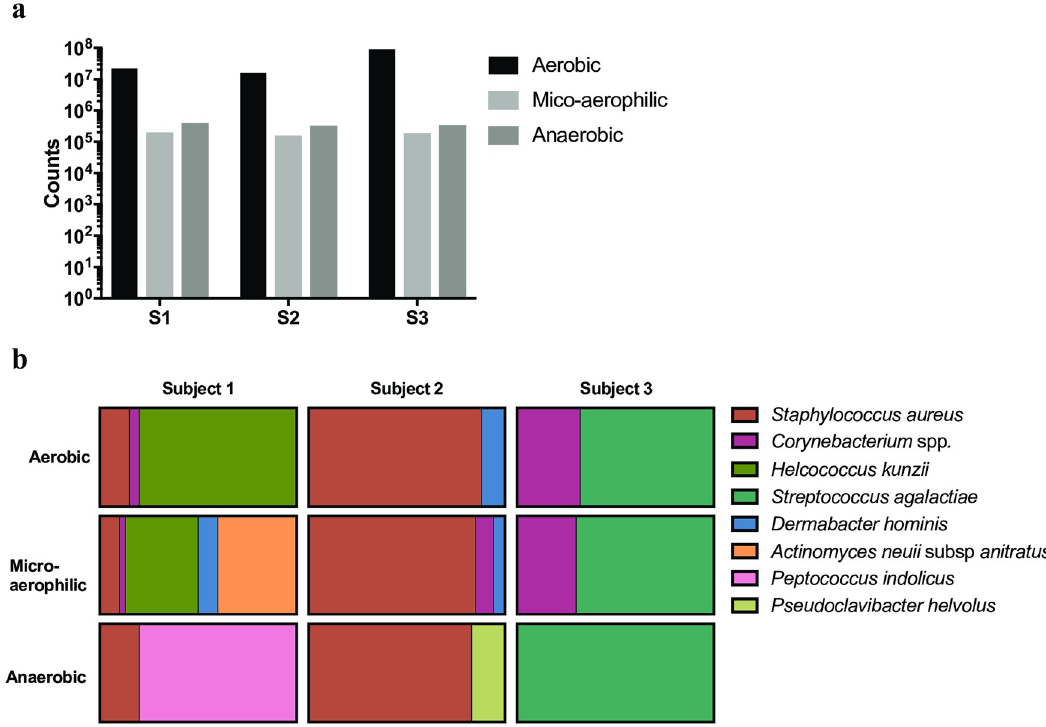
Fig 3. Bacteria were harvested from tissue debrided from DFIs and identified. A sample of debrided tissue was collected from three subjects, homogenised and grown under aerobic, microaerophilic and anaerobic conditions. The counts from each sample are shown in (a). The bacterial identities and proportions for each sample under all three growth conditions are shown as a percentage using parts of whole analysis